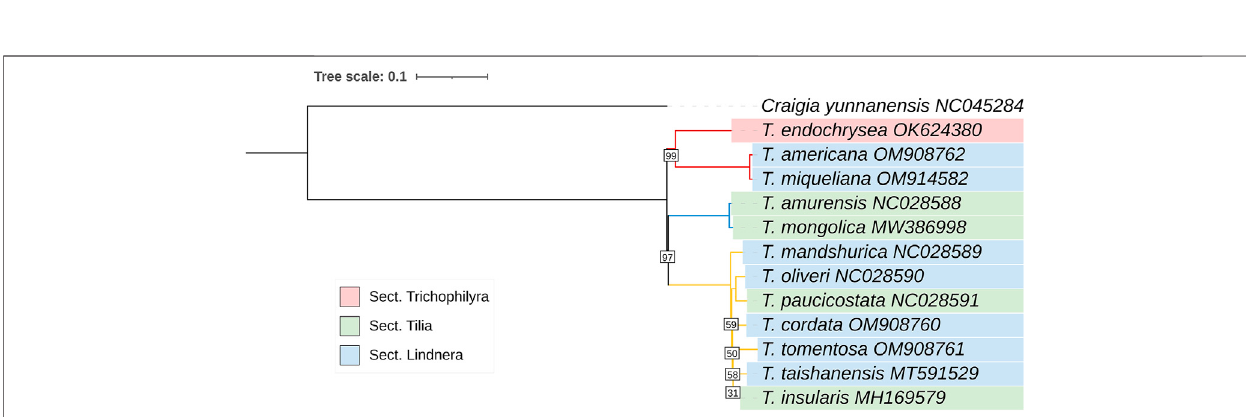
Frontiers in Genetics |